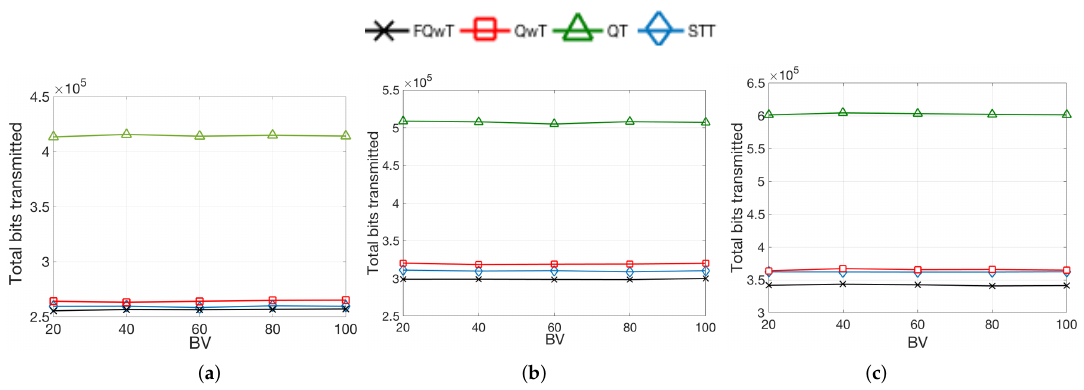
Figure 12. Simulation results obtained for total transmitted bits when d = 1; FPL is 20, 60, and 100; and, BV varies from 20 to 100%. ( a ) FPL = 20; ( b ) FPL = 60; ( c ) FPL = 100.